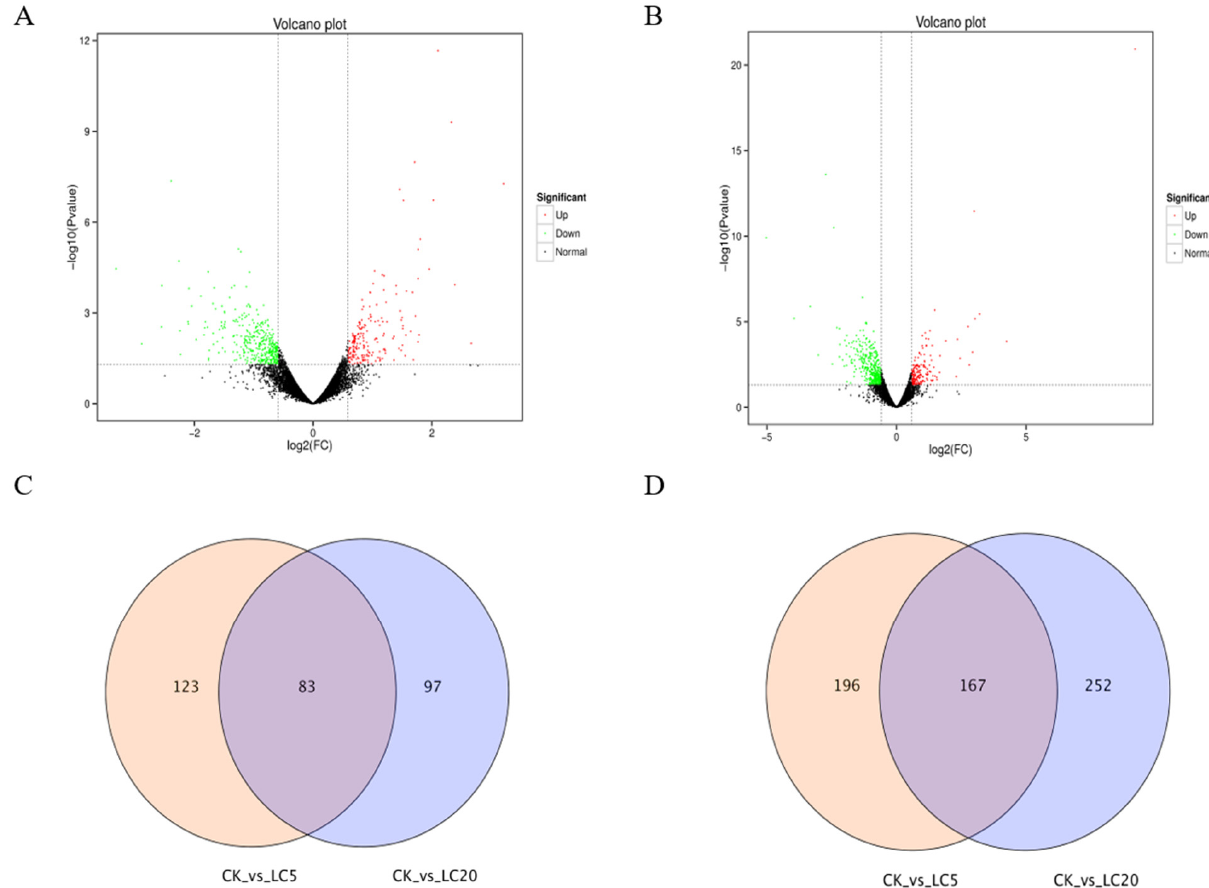
Figure 3. Bioinformatics analysis of differentially expressed genes (DEGs). ( A ) DEGs distribution of the control group (CK) and low concentration treatment group (LC 5 ); ( B ) DEGs distribution of CK and high concentration treatment group (LC 20 ); ( C ) Venn diagram of upregulated DEGs; ( D ) Venn diagram of downregulated DEGs.